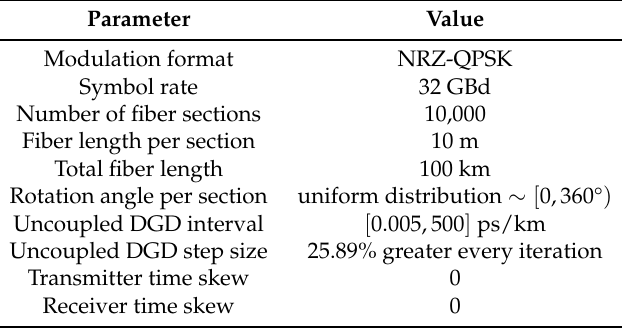
Table 2. Parameters for evaluation of CTA due to PMD in single-mode fiber